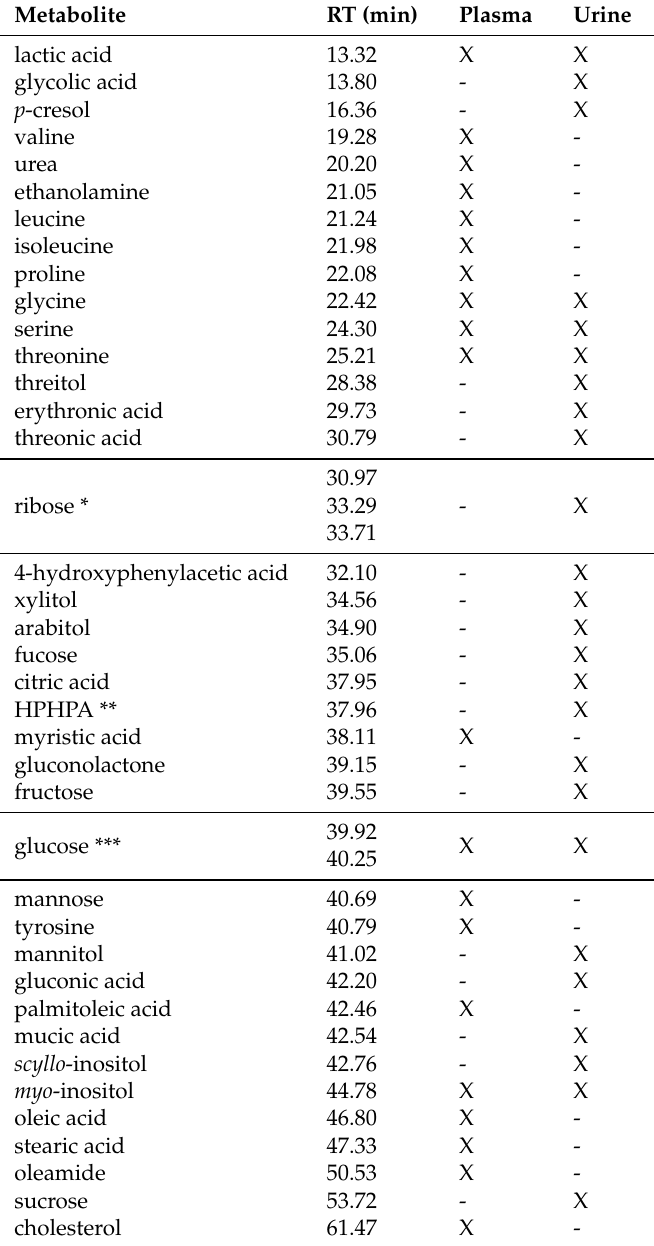
Table 1. List of metabolites included in the merged